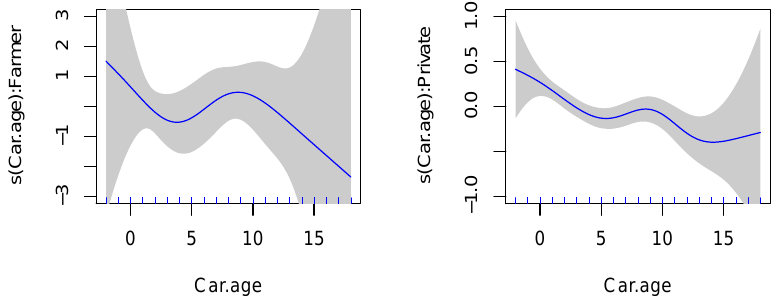
Figure 12. The plots of fitted spline functions for Car Age, separated by Car